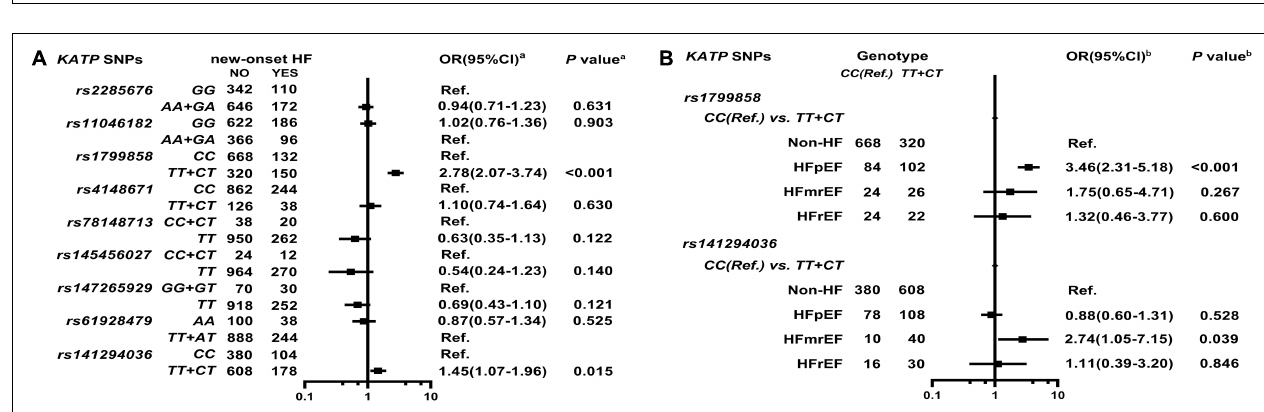
( TT + CT , adjusted OR = 1.47, 95% CI: 1.10–1.96, P = 0.009), rs2285676 ( AA + GA , adjusted OR = 1.42, 95% CI: